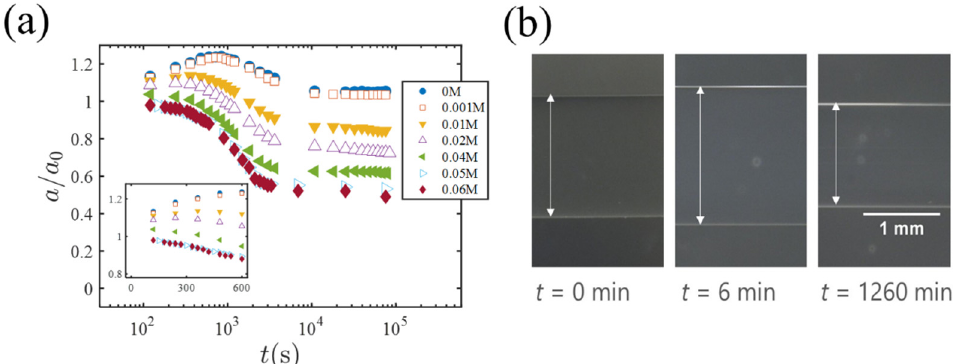
Figure 3. ( a ) The time change of the gel radius a ( t ) (normalized by the initial radius a 0 = a ( 0 ) ) during the solvent exchange. The different plot symbols represent different PEG concentrations in the outer solution. The insert is a linear plot showing the short-time behavior. ( b ) Photos of a gel specimen ( C PEG = 0.01 M) at different times.